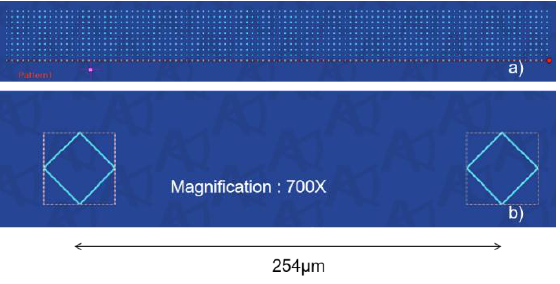
Figure 3. ( a ) Indention pattern on the transverse cross-section of the weld; and ( b ) distance between two indent at 700× magnification.